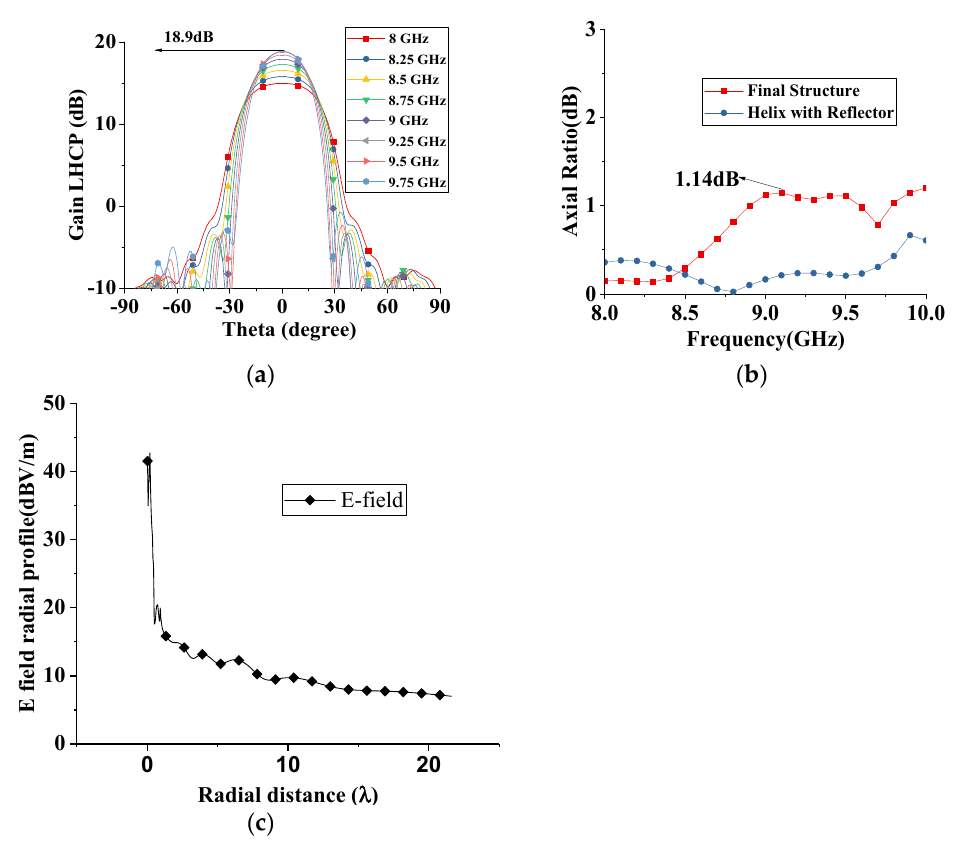
Figure 10. ( a ) Radiation patterns of the whole structure for entire working band ( b ) Axial ratio for helix and final structure in entire operational band ( c ) Electric field radial profile of presented antenna.